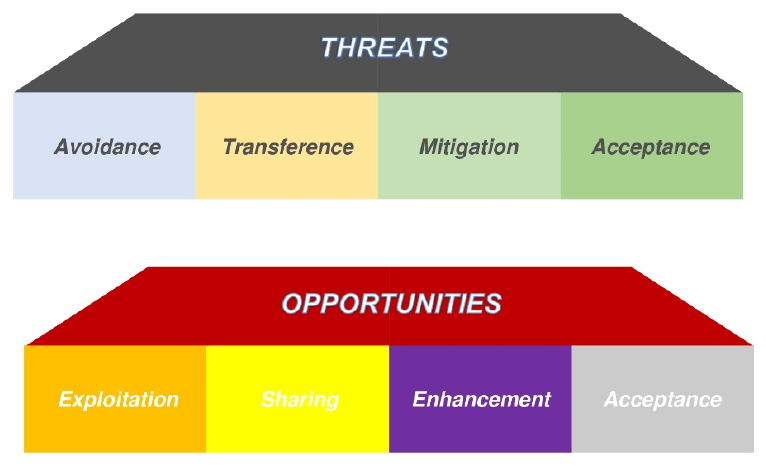
Figure 3. Aspects of